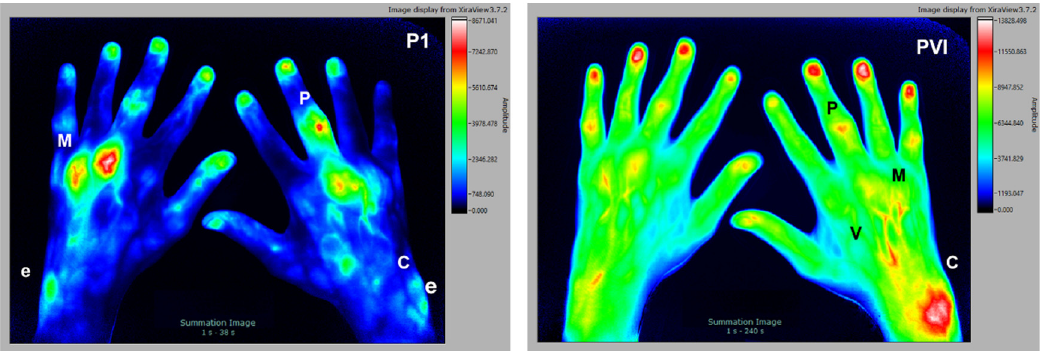
Figure 2. The 45 y/o male patient with clinical diagnosis of rheumatoid arthritis. Signal enhancement seen in MCP (M), PIP (P), carpal articulation region (C), extensor carpi ulnaris (e) region, and venous vessels (V).